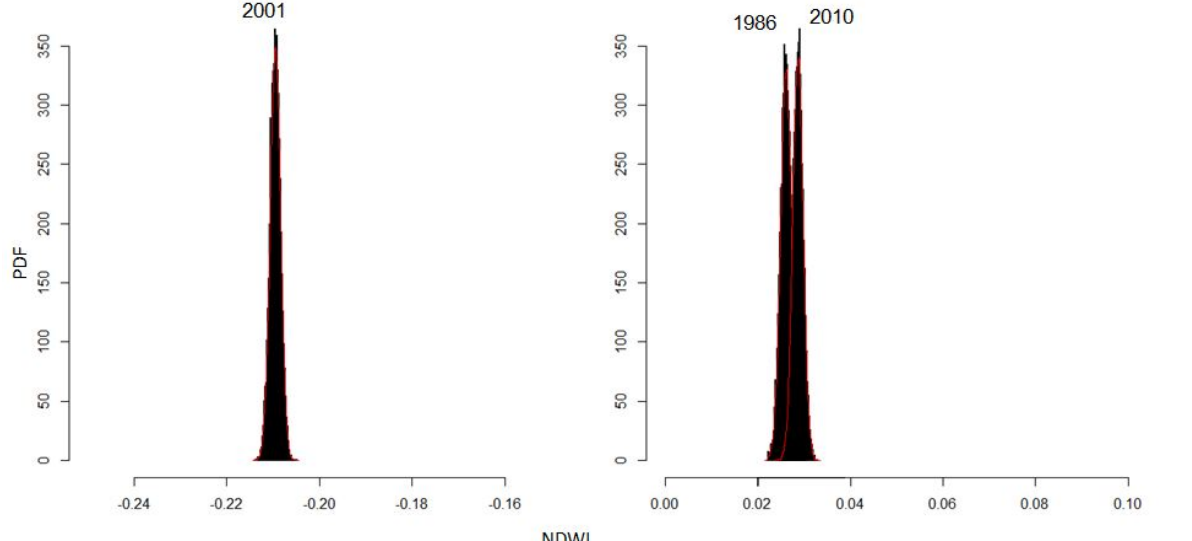
Figure 9. Probability density function calculated from the MCM of the